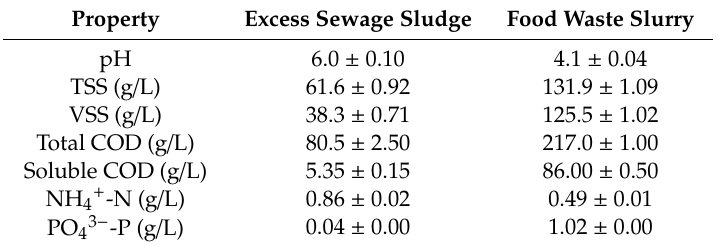
Table 1. Characteristics of the excess sewage sludge and food waste